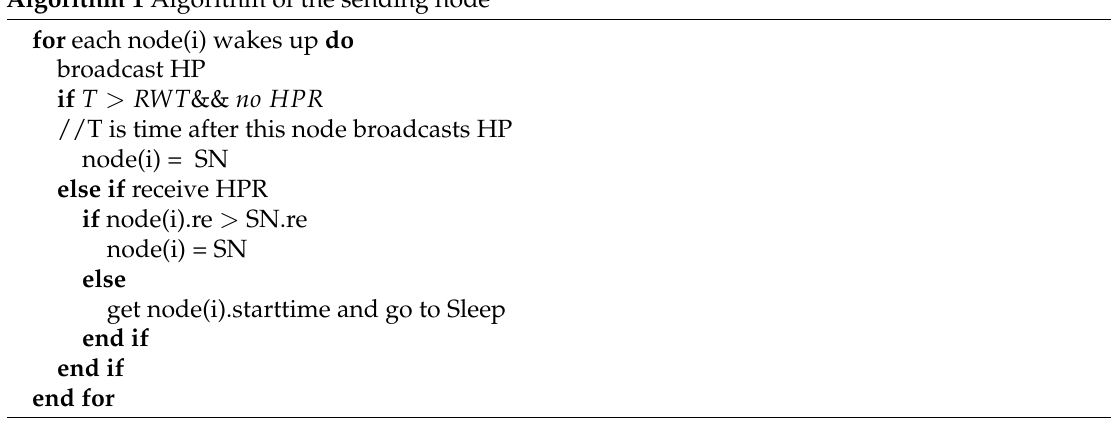
Algorithm 1 Algorithm of the sending node